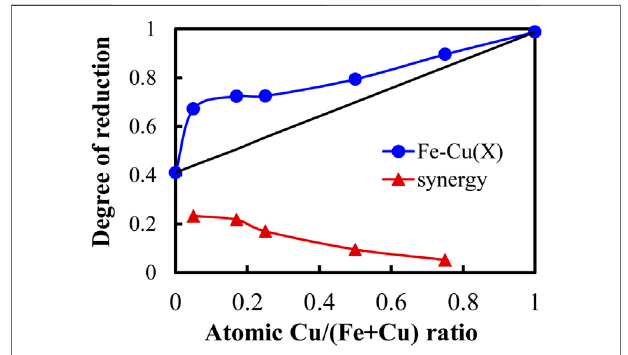
FIGURE 2 | The degree of reduction (DR) as a function of atomic Cu/(Fe + Cu) ratio for Fe-Cu(X)/Al 2 O 3 catalysts measured by H 2